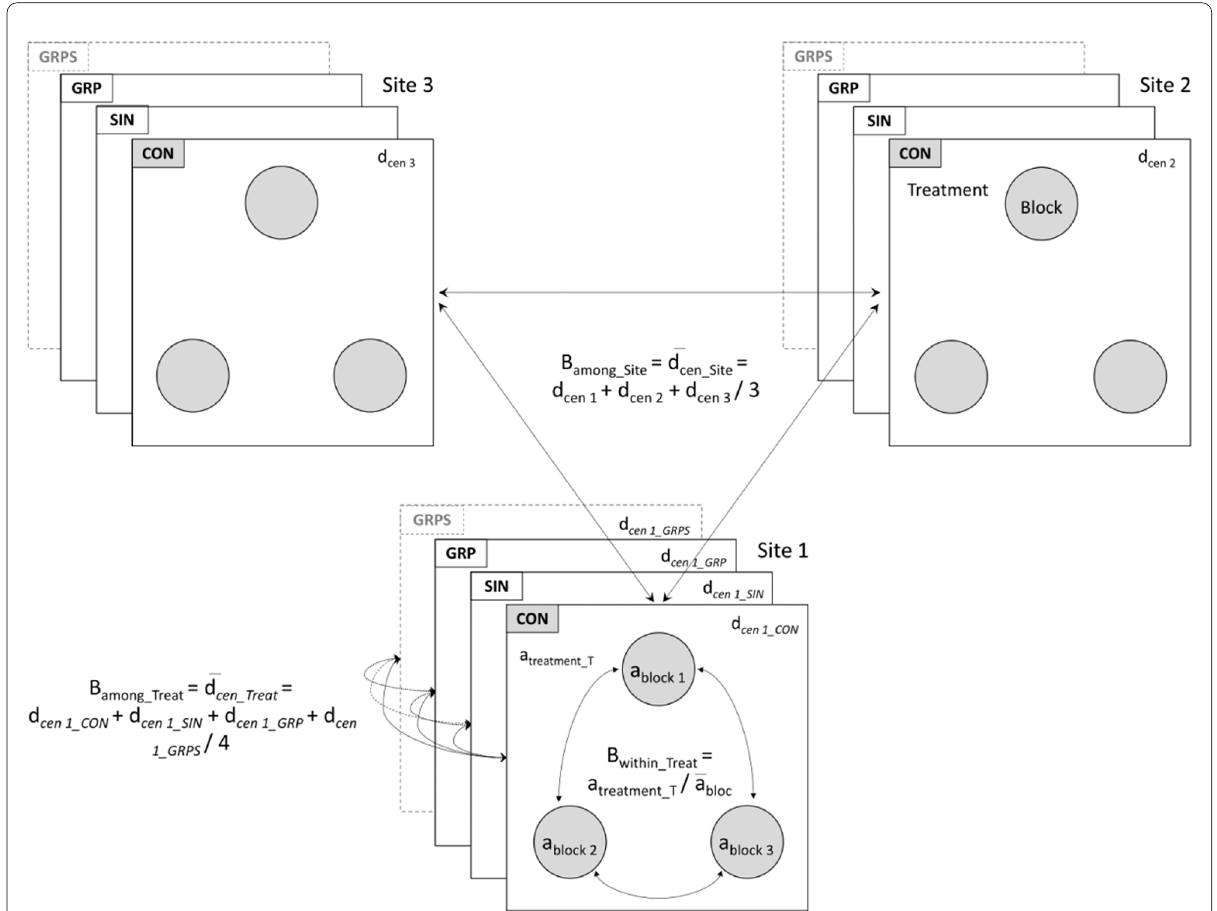
Fig. 5 Different spatial scales involved in the beta diversity calculations. Beta diversity was calculated within each site for a given treatment ( B within_Treat ), within each site among treatments ( B among_Treat ) and among sites for each of the treatments ( B among_Site ), adapted from Royer-Tardif et al. (2018). CON: control, SIN: single-tree selection cut, GRP: group-selection cut, GRPS: group-selection cut with soil